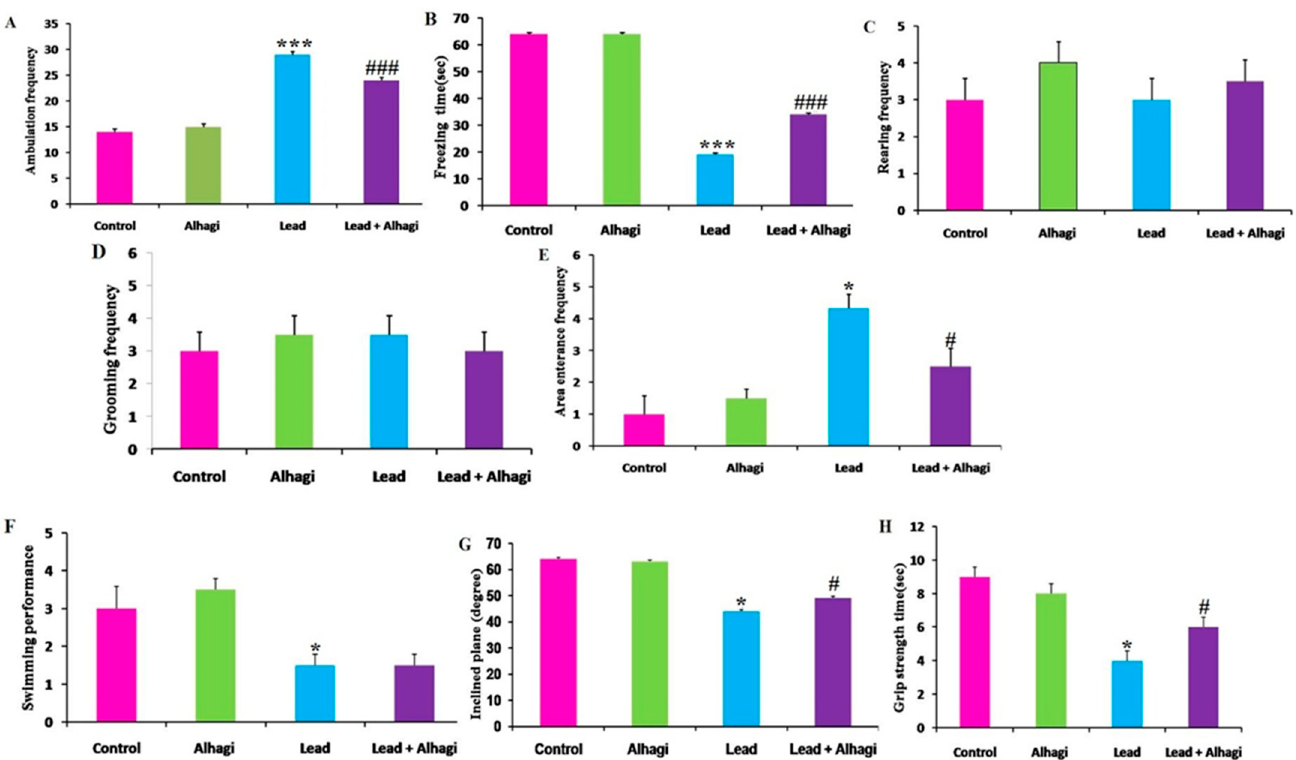
Figure 2. Effect of A. maurorum extract on open field test parameters (ambulation frequency ( A ), freezing time ( B ), rearing frequency ( C ), grooming frequency ( D ), and central area entrance frequency ( E ), swimming performance ( F ), inclined plane test ( G ), and grip strength time ( H ) in the lead-treated rats. Data were expressed as mean ± SE, n = 10 for each group. *, *** Significantly different compared to the control group at p < 0.05 and p < 0.001, respectively. #, ### Significantly different compared to the lead-exposed group at p < 0.05 and p < 0.001, respectively.